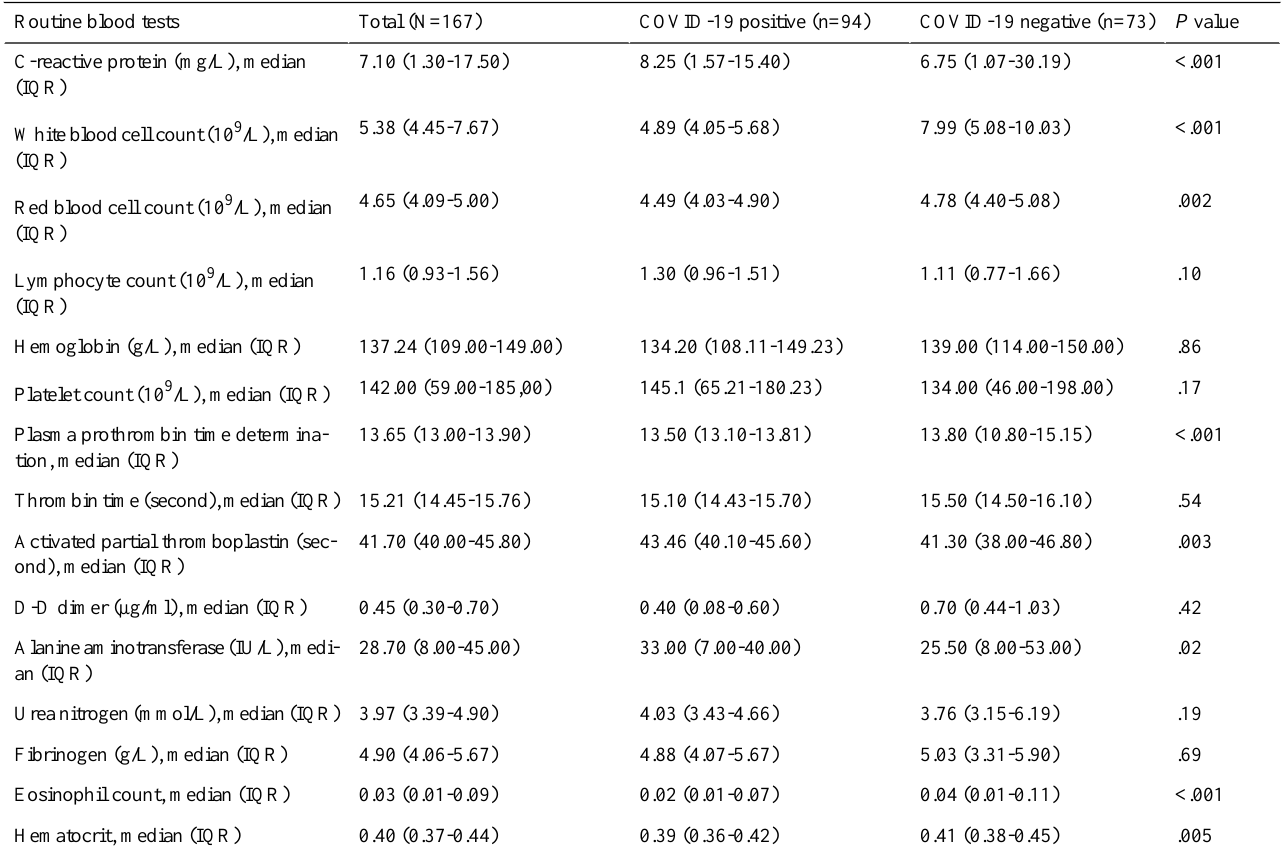
Table 2. The results of routine blood tests from the clinical